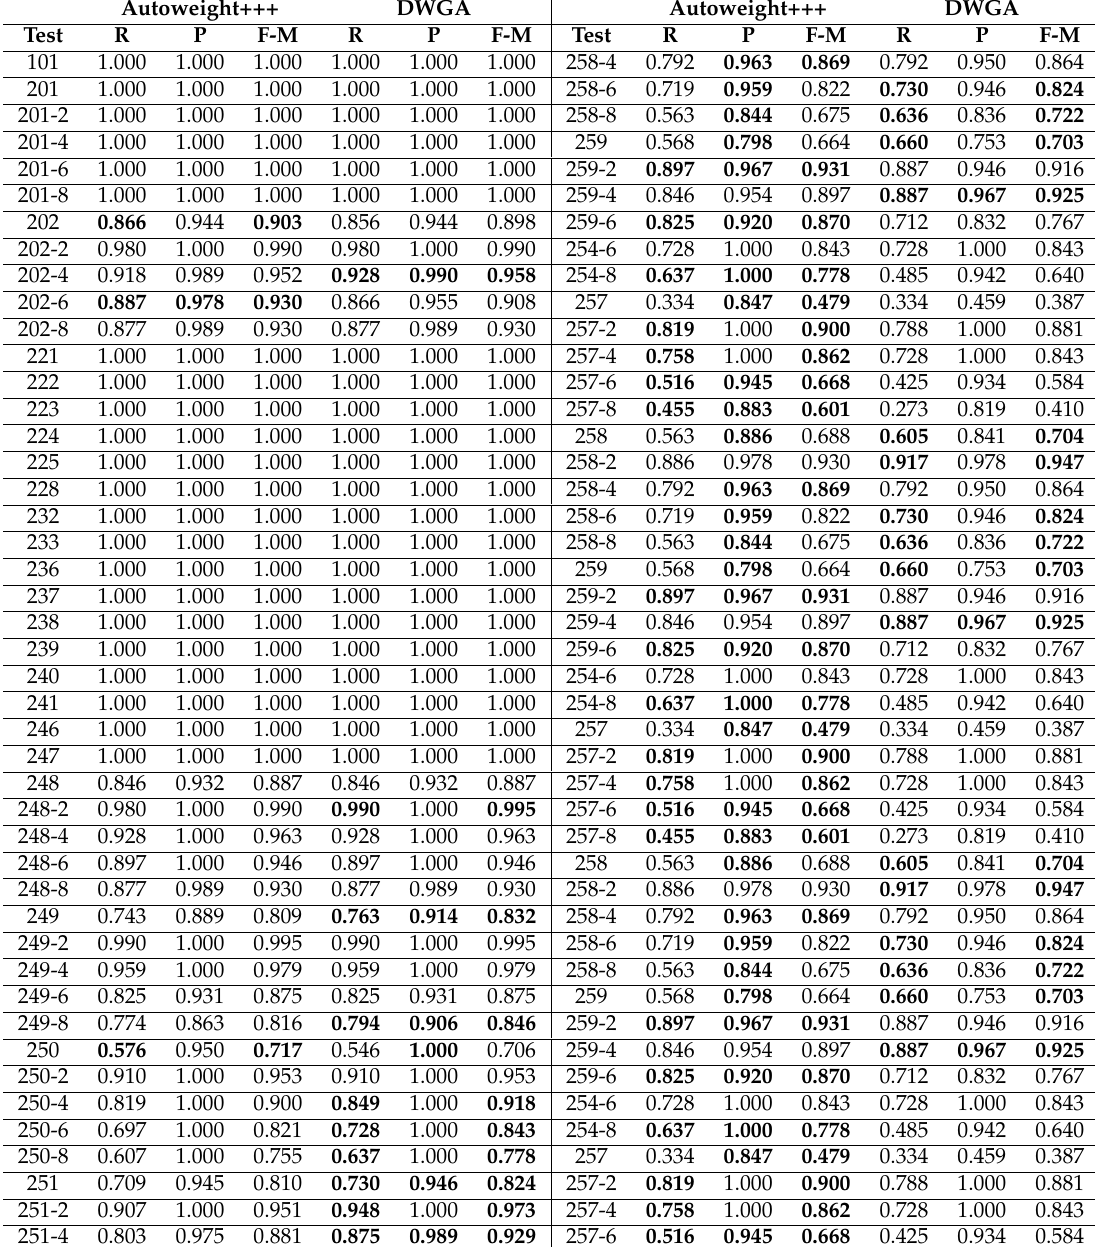
Table 1. The results of each test case within the Benchmark biblio ontology track obtained by two versions of CroMatcher system (Autoweight+++ method vs. DGWA